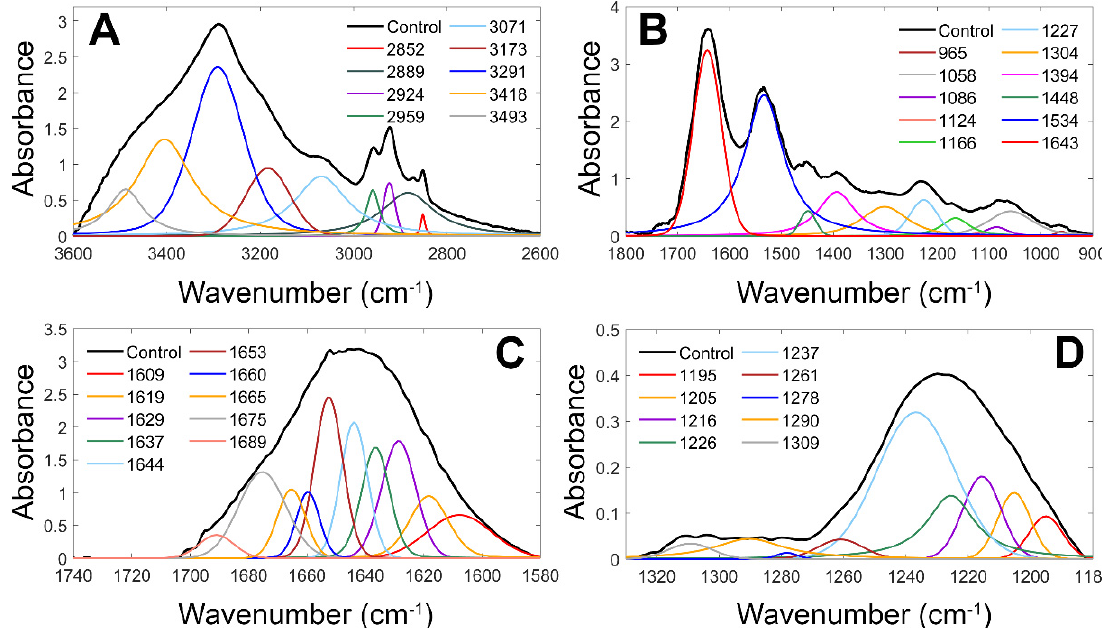
Figure 2. Deconvolution of a μ FTIR spectrum acquired from normal human MCF-10A breast cells in the different spectral regions. In the ( A panel) the high wavenumber region (3600–2600 cm − 1 ) is shown, in the ( B panel) the same is shown for the fingerprint region (1800–900 cm − 1 ), in the ( C panel) the same is shown for the Amide I band region (1740–1580 cm − 1 ), and in ( D panel) the same is shown for the Amide III band region (1350–1180 cm − 1 ). Reprinted from Reference [19] under open access conditions. Table 1. FTIR peaks observed in the spectrum of MCF-10A breast cells, with assignments in agreement with the data reported in the literature (see Reference [19] and references therein); as = asymmetric, s = symmetric, ν = stretching, δ = bending, sc = scissoring, vbr = vibration, a. a. = free amino acids. The indicated position of every peak is the center of the relative Gauss-cross-Lorentzian function obtained from the deconvolution